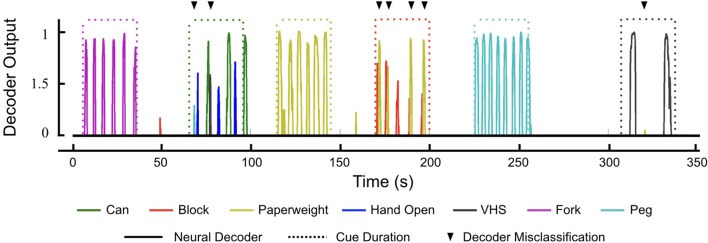
Neural decoder outputs during the GRT. Representative decoder outputs during a GRT test block showing instances of decoder misclassification (black triangles). All seven hand movements are available to the participant as part of the decoder and he has to evoke the correct movement (solid lines) during the 30 s trial period (dotted lines) given to him to complete the GRT for that object. Only decoder outputs above the activation threshold of zero are shown for visual clarity. Successful transfer of Can required the participant to evoke two hand movements—Hand Open and Can grasp (70–100 s). During the Can transfer, the decoder had two misclassifications (one of each for the PEG and VHS grasps). However, the participant was able to evoke the correct hand movements to successfully complete two Can transfers during the trial period. Similarly, during the Block transfer (170–200 s), the participant incorrectly evoked the decoder for Paperweight on four occasions. This did not affect the GRT scores for the Block, however, as the decoder for Paperweight kicked in after the participant had completed the Block transfer.